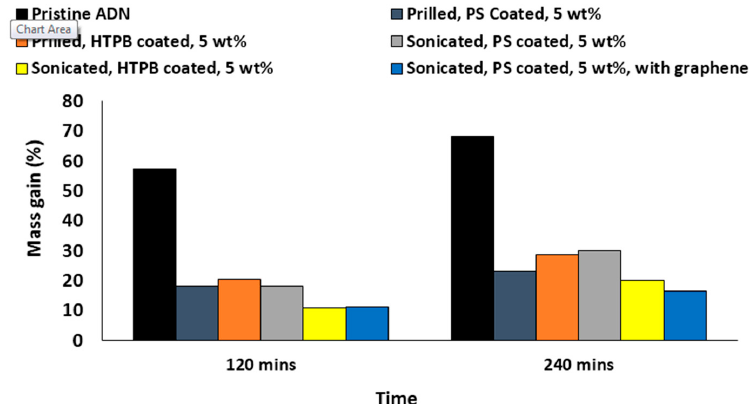
Figure 6. Mass gain in pristine ADN, melt prilled, and sonicated coating of the ADN particle.